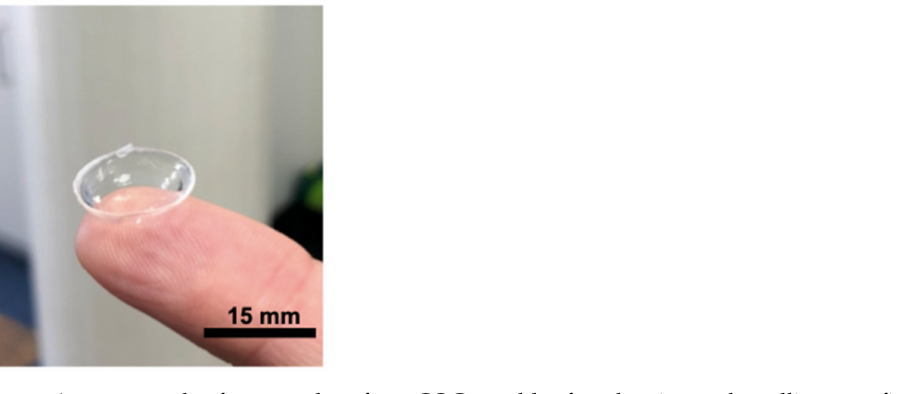
Figure 2. A prototyped soft contact lens from COC moulds after cleaning and swelling on a finger for scale.